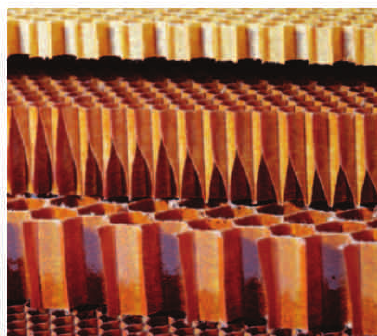
Fig. 3. Selected mechanical properties of plastics in comparison Fig. 2. Composites reinforced with amide fibers with a macromolecular structure